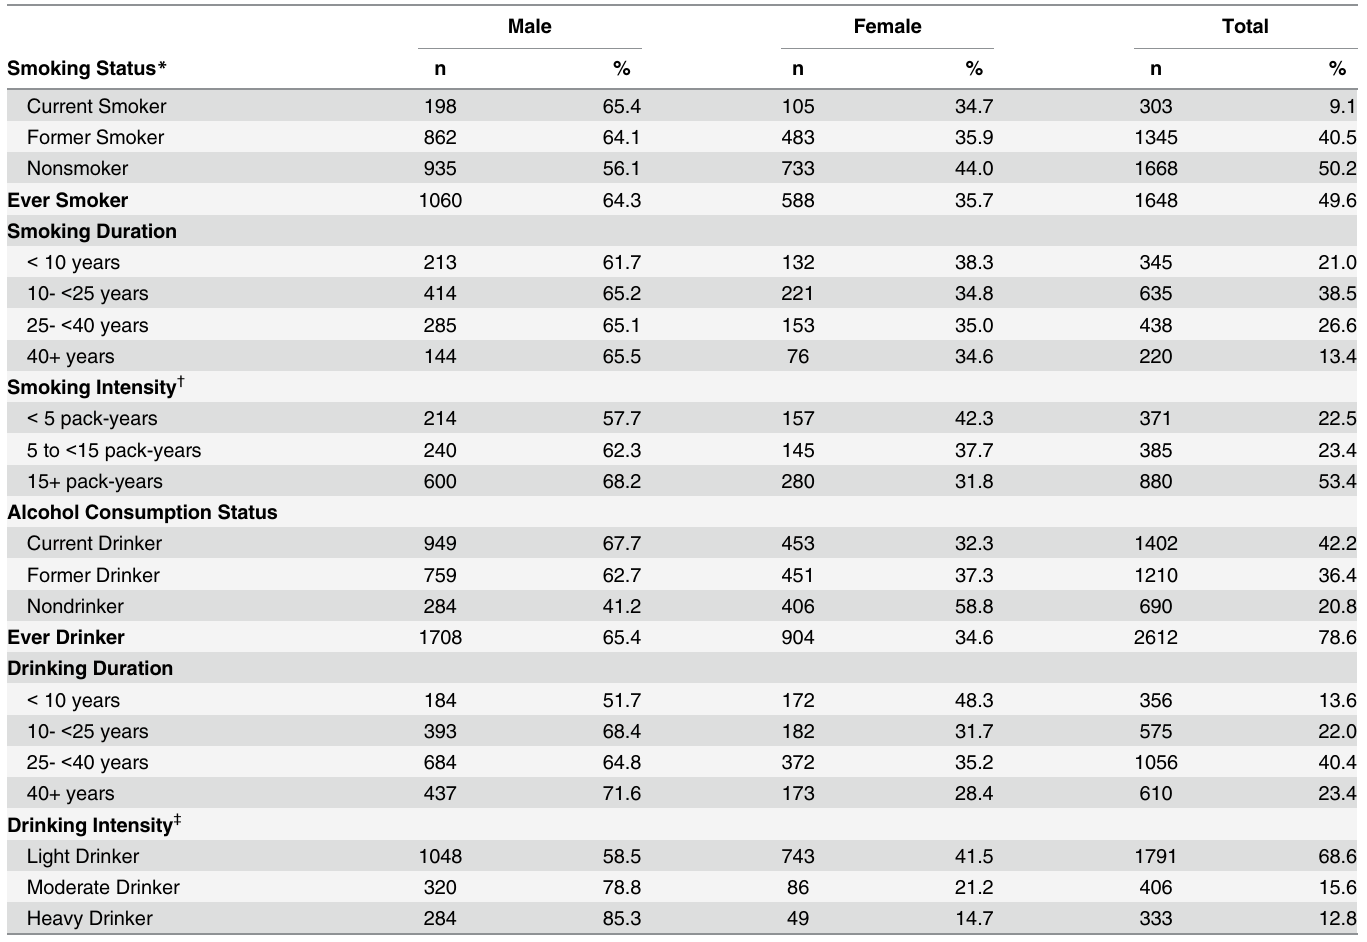
Table 2. Risk Behaviors among Adults with ALS (October 19, 2010 – December 31,